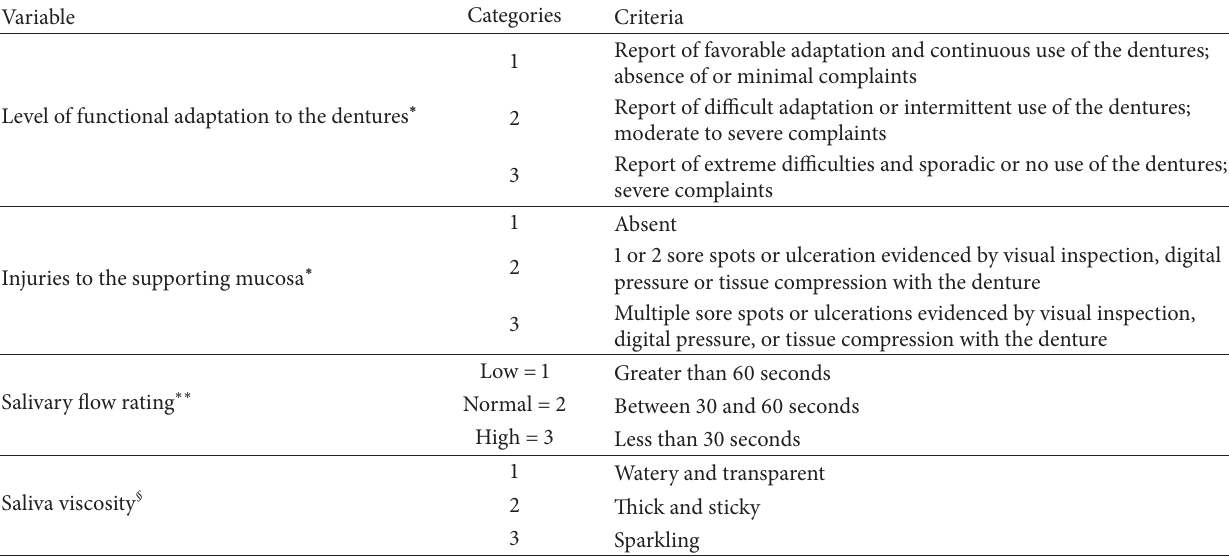
Table 1: Classification of clinical parameters.